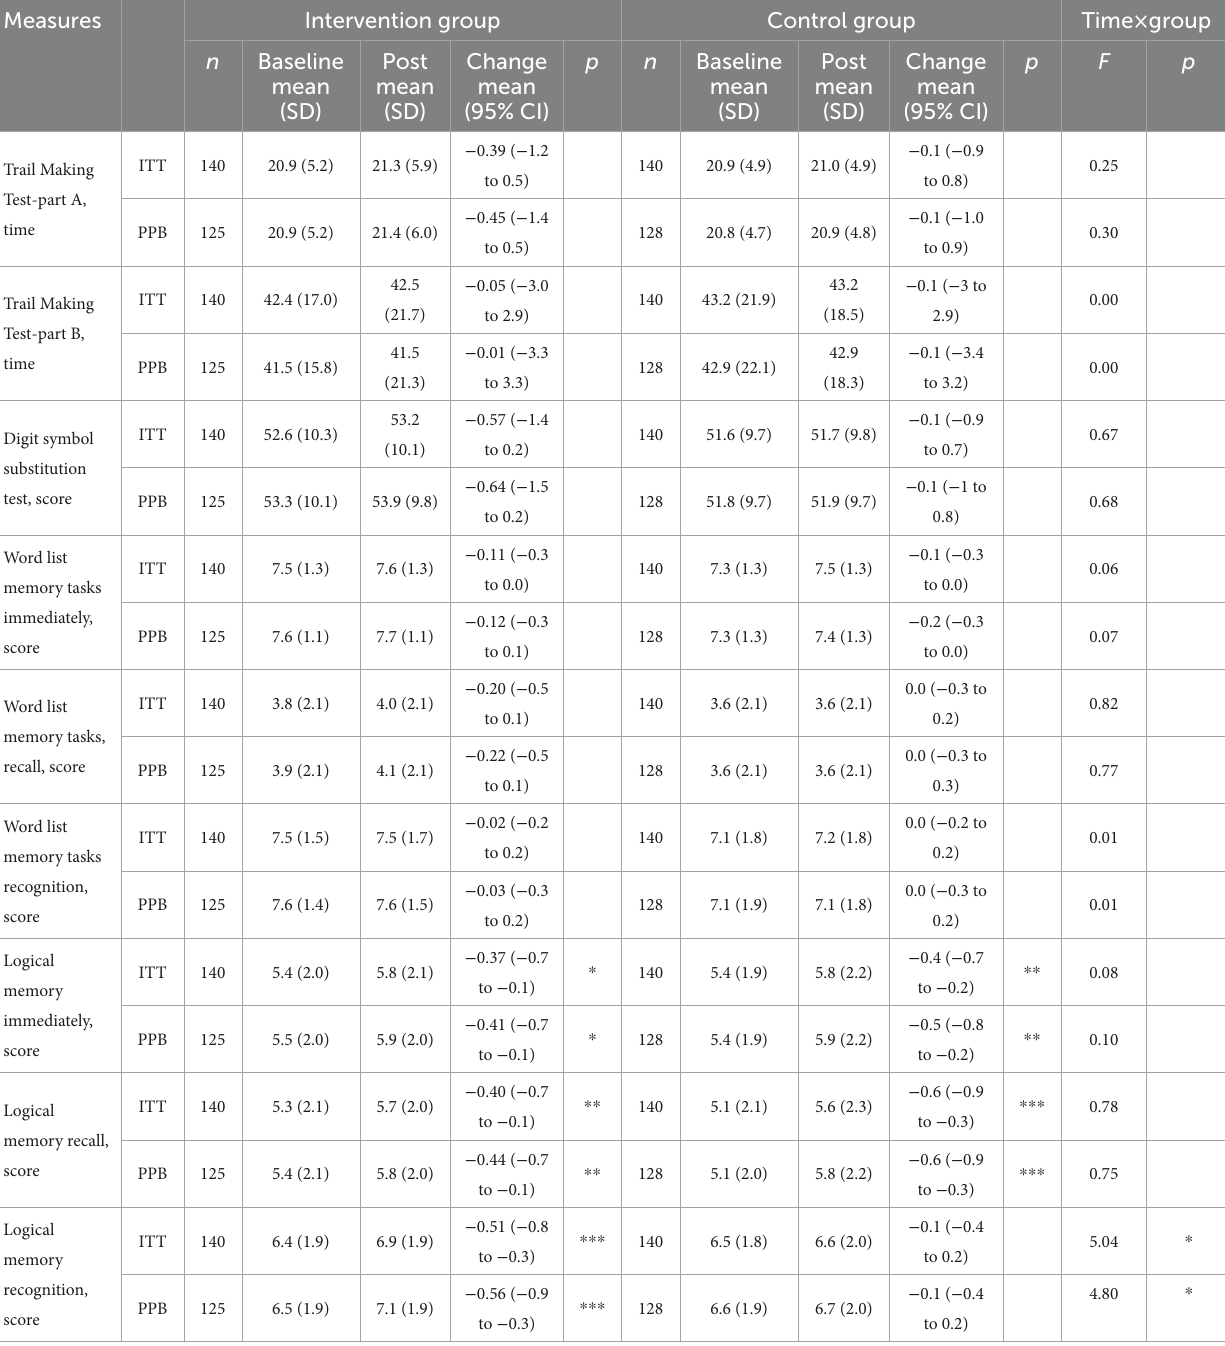
TABLE 2 Effects of the intervention and time on the primary outcomes among older adults (Intention-to-treat method and per protocol based).